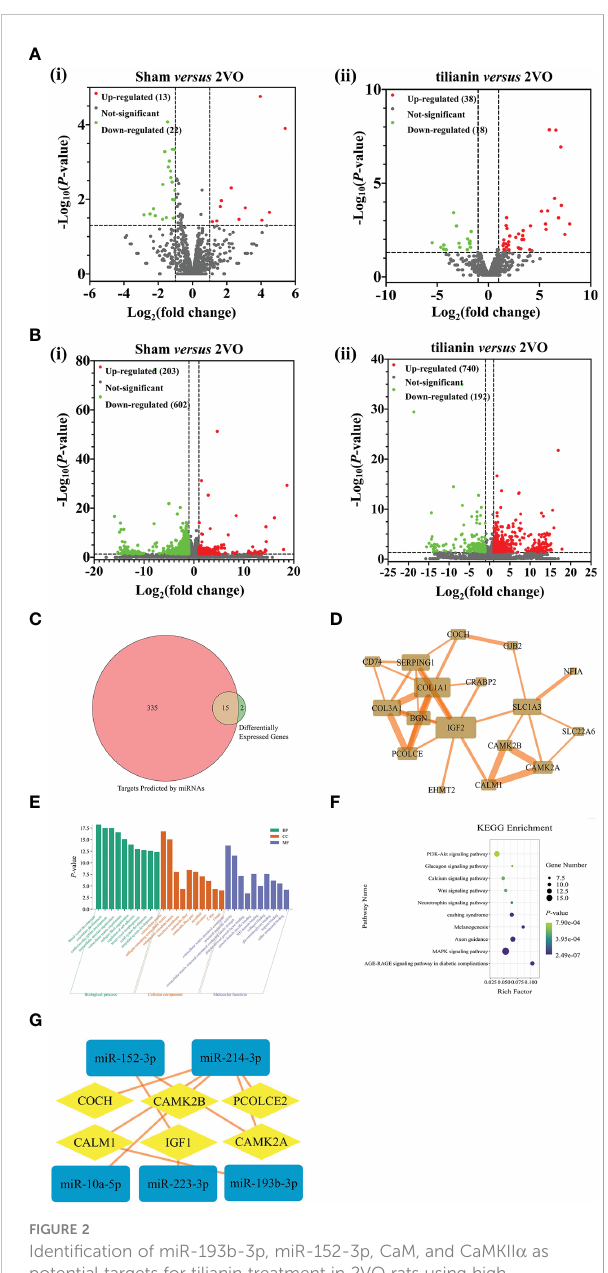
FIGURE 2 Identi fi cation of miR-193b-3p, miR-152-3p, CaM, and CaMKII a as potential targets for tilianin treatment in 2VO rats using high- throughput sequencing analysis. (A) Volcano plots of differentially expressed miRNAs in the cortical tissues of 2VO rats after tilianin treatment. (i) Comparison between the 2VO model and sham groups. (ii) Comparison between the tilianin treatment and 2VO model groups. (B) Volcano plots of differentially expressed mRNAs in the cortical tissues of 2VO rats after tilianin treatment. (i) Comparison between the 2VO model and sham groups. (ii) Comparison between the tilianin treatment and 2VO groups. (C) Venn diagram of the intersection of miRNA-predicted targets and differentially expressed genes. (D) Network diagram of protein- protein interactions of 15 core targets. (E) Top 10 signi fi cantly enriched GO terms. (F) Top 10 signi fi cant KEGG pathway terms. (G) Interaction network diagram of differentially expressed miRNA and mRNA after tilianin treatment in